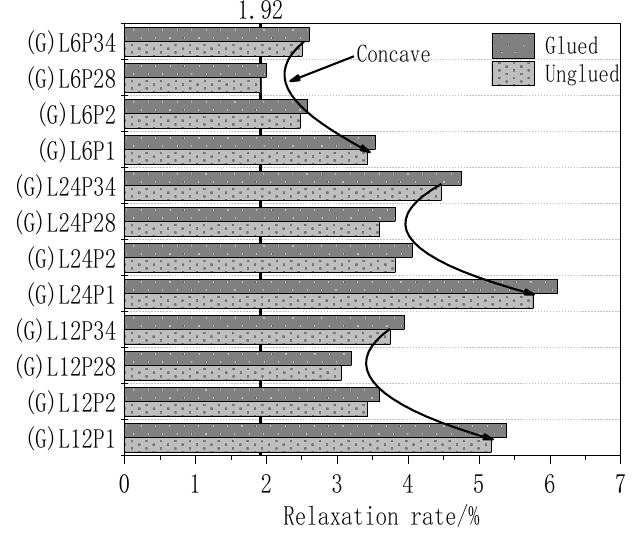
Figure 9. Post-168 h histogram of the relaxation rate of specimens under different treatments.